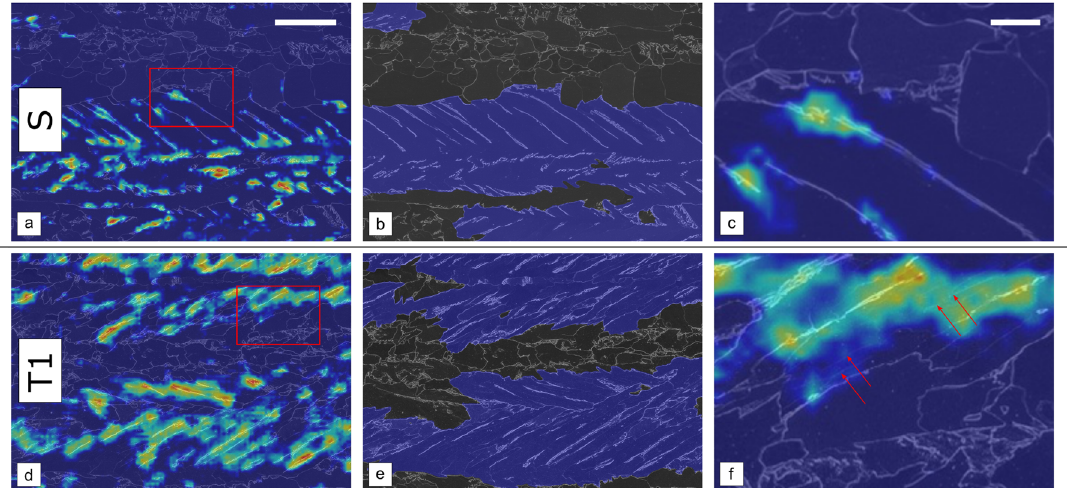
Fig. 5 Network visualizations of the ResNet-101 DeepLabv2 model, on the source (S.10, a – c) and target 1 (T1.10, d – f) domain with lath- shaped bainite labels (b) and (e) given as reference. The heat maps indicate regions that were taken into consideration at layer 3_16 of the ResNet-101 40 to classify the lath-shaped bainite regions. In the detail views ( c ), ( f ), which are the same as in Fig. 1, heat maps in the target 1 domain are more extensive and additionally incorporate subgrain boundaries (red arrow annotations). The scale bar in ( a ) applies to the fi rst and second column and its width corresponds to 10 μ m, while the third column scale bar width amounts to 2 μ